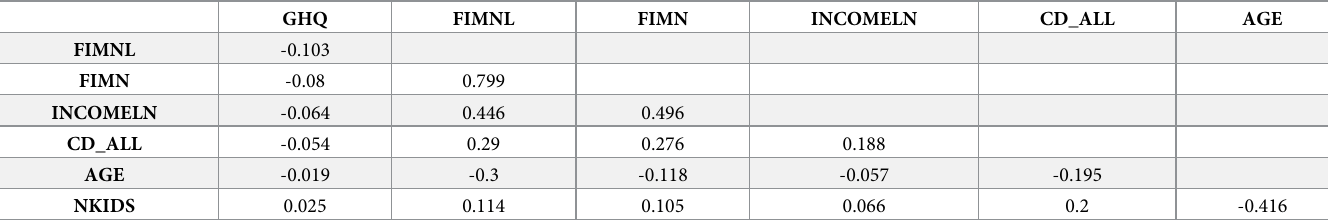
Table 2. Pairwise correlation matrix for all